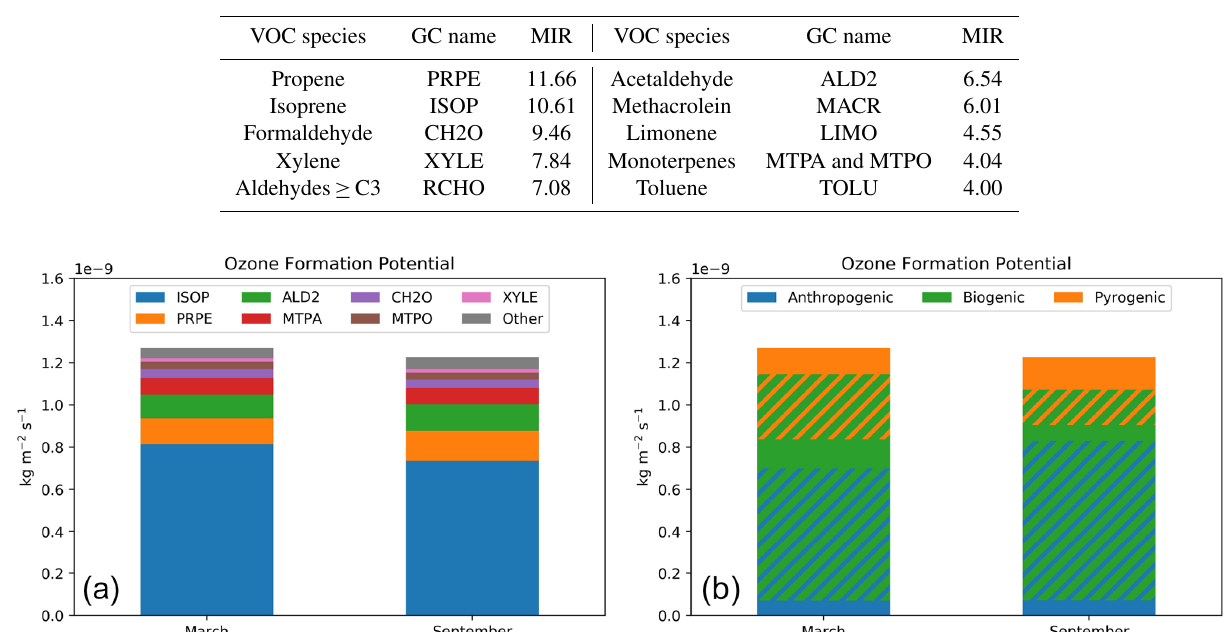
Figure 9. Mean ozone formation potential (kgm − 2 s − 1 ) for Southeast Asia in March and September 2014 sorted by (a) individual species of emitted NMVOCs and (b) the source sector of emitted NMVOCs. Blue and orange hatching shows OFP from biogenic NMVOCs, scaled by the fraction of NO x emissions that are attributed to anthropogenic and pyrogenic sources,